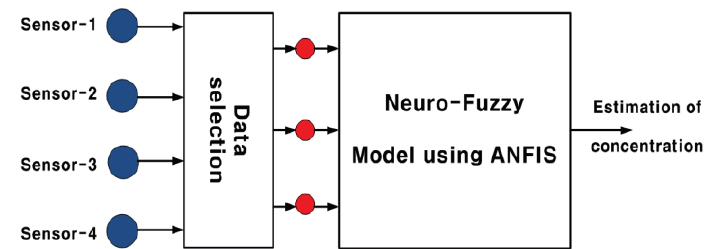
Figure 6. Concentration estimation algorithm using a neuro-fuzzy model.